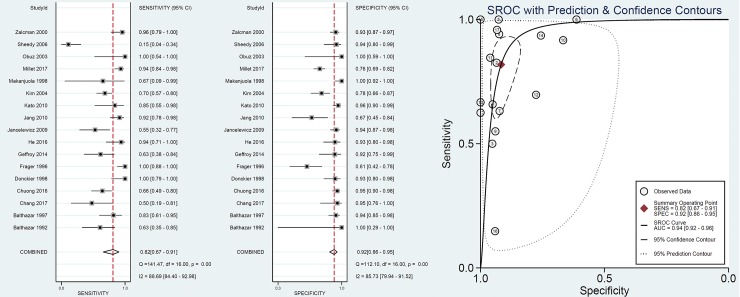
Value of CT in diagnosis of ischemia.